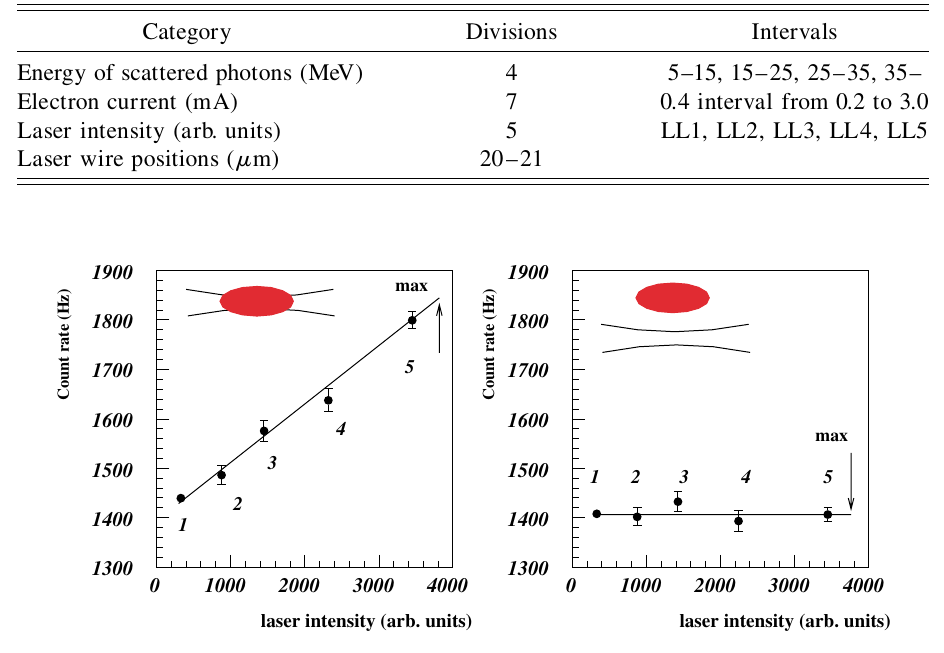
FIG. 7. (Color) Count rate versus the laser intensity. The laser wire was on (left) and off (right) the electron beam.